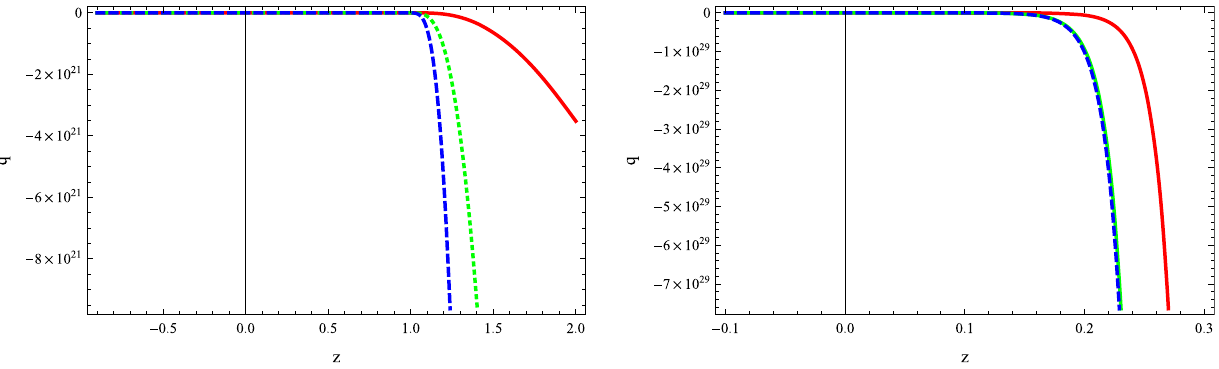
Fig. 12 Plots of unified phases deceleration parameter q for u = 2 (left) and − 2 (right). Also, H 2 = 2 . 7 (red), H 2 = 2 . 75 (green) and H 2 = 2 . 8